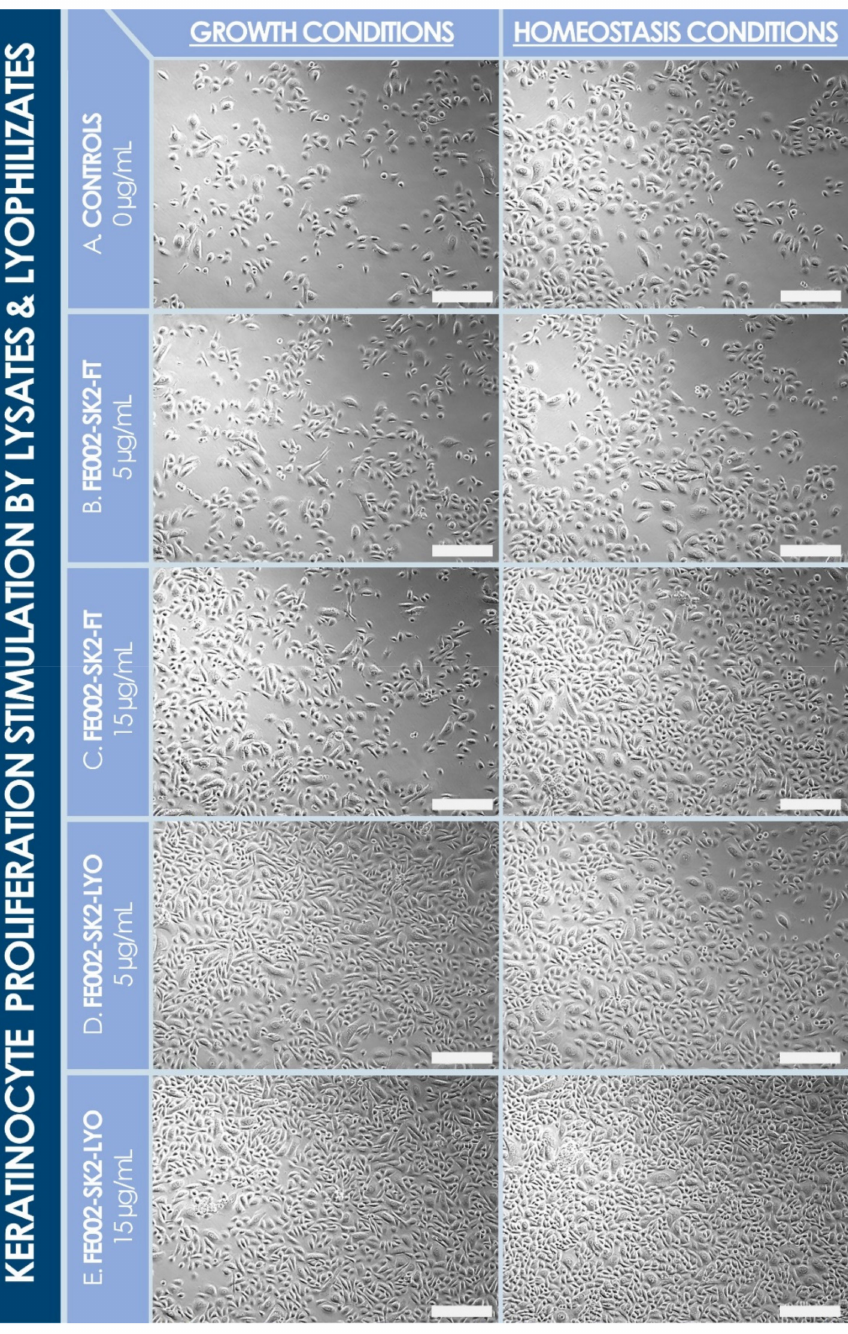
Figure 5. Primary keratinocyte proliferation stimulation potential of various doses (i.e., expressed in normalized total protein contents at the final dilution in the culture medium) of dermal FPC (e.g., FE002-SK2 cell type) lysates (i.e., “FT” for freeze-thaw) and lyophilizates (i.e., “LYO”, formula B), respectively. Photographic imaging was performed in both culture conditions (i.e., growth and homeostasis conditions) after an incubation period of 96 h. ( A ) Control group. ( B ) Lysate group at a concentration of 5 µ g/mL. ( C ) Lysate group at a concentration of 15 µ g/mL. ( D ) Lyophilizate group at a concentration of 5 µ g/mL. ( E ) Lyophilizate group at a concentration of 15 µ g/mL. Visual assessment indicates a positive effect of lyophilizates on keratinocyte proliferation at investigated doses, as compared to cell lysates and controls, respectively. Scale bars = 150 µ m. FPC, fibroblast progenitor cells; FT, freeze-thaw; LYO,